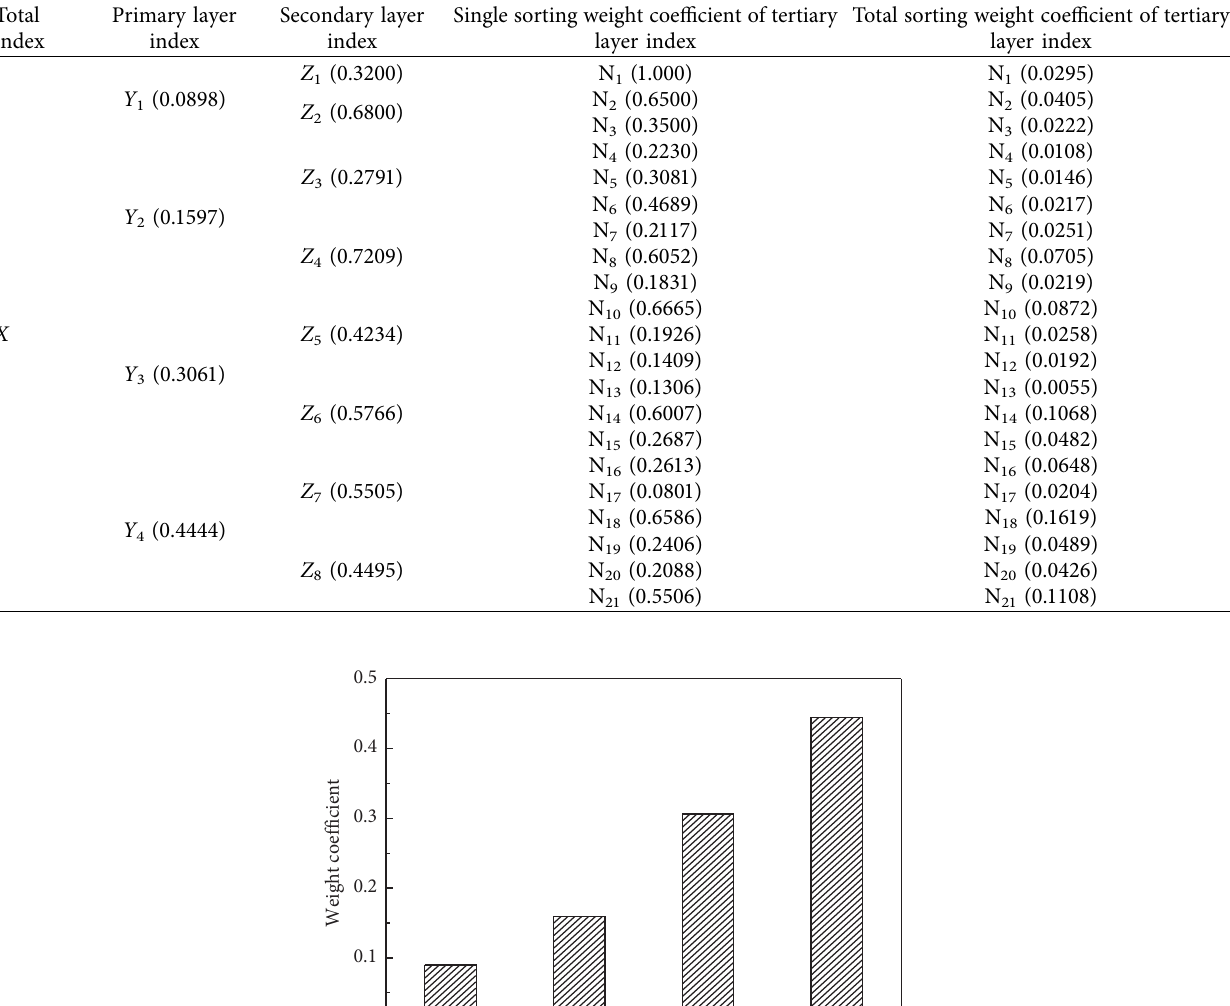
Table 6: Index weight coefficient of single sorting and total sorting of assessment index layer of E&I education effect in colleges.